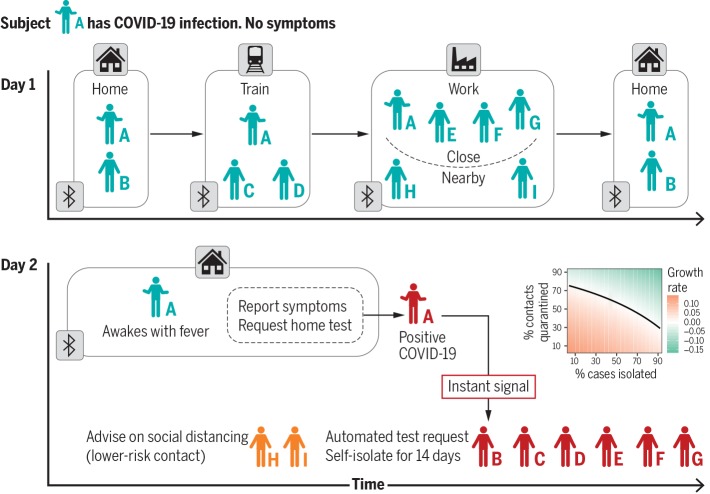
Instant contact tracing can reduce the proportion of cases that need to be isolated and contacts who need to be quarantined to achieve control of an epidemic.Subject A becomes symptomatic after having had contact with other people in different settings the day before. Contacts are notified and quarantined where needed. In the inset, the green area indicates the success rates needed to control an epidemic with R0 = 2 (i.e., negative growth rates after isolating cases and quarantining their contacts).